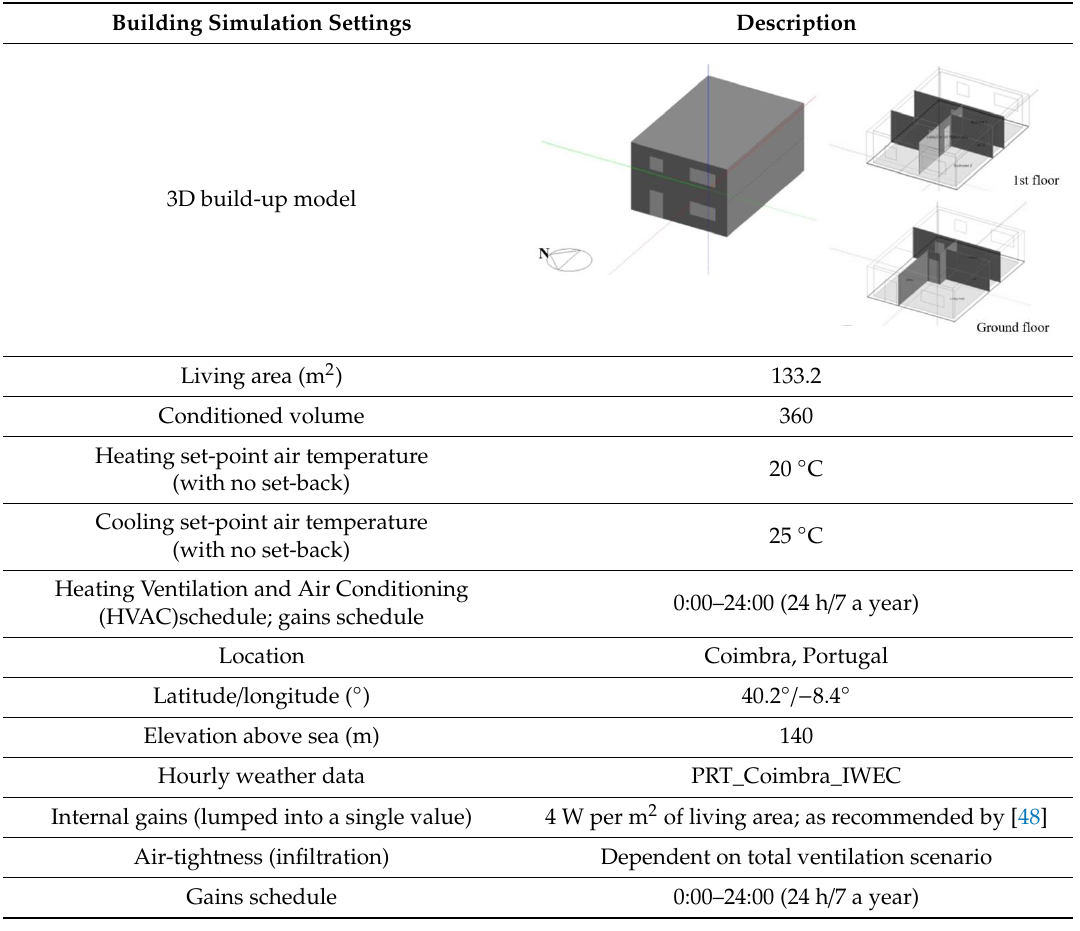
Table 4. Building simulation settings, OP100.